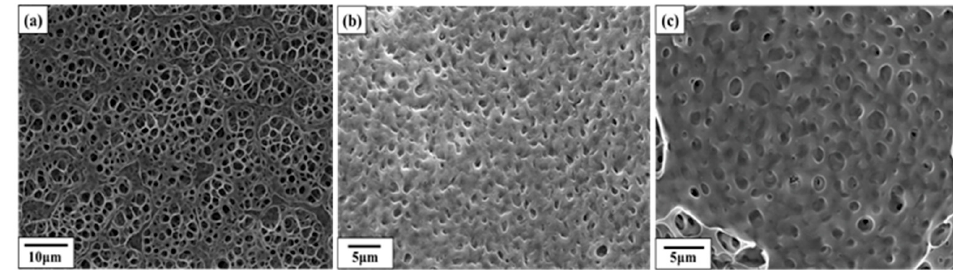
Figure 2. Images of ( a ) the neat PP film and ( b ) the PP side of the PP/AC/Gly at 10 bar.